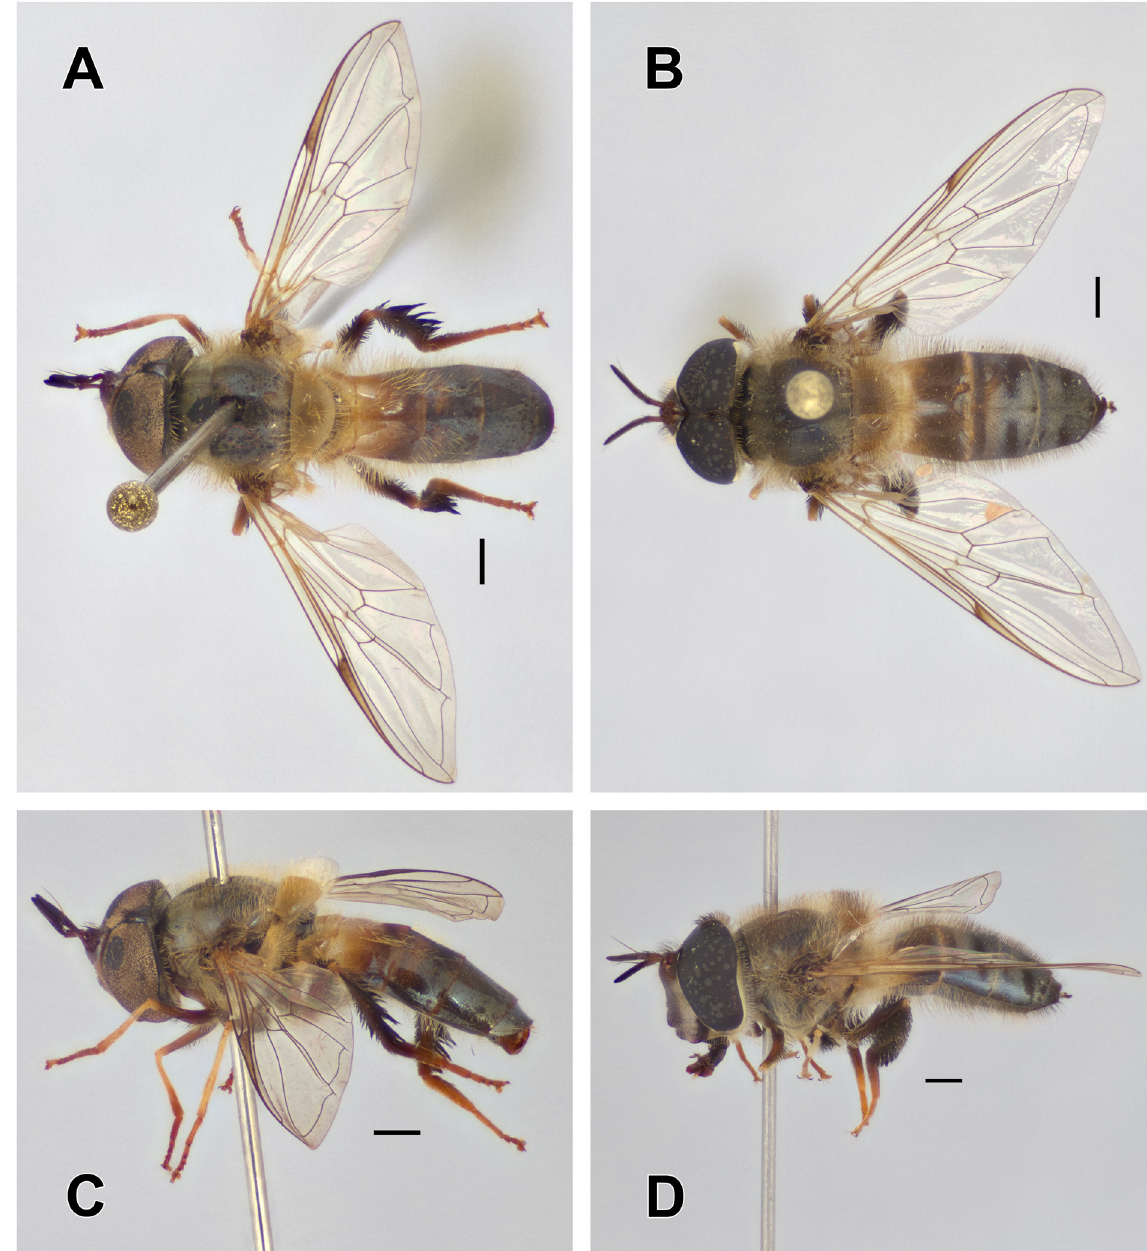
Fig. 3. A . Afrosyrphus varipes Curran, 1927, ♂ (ZFMK-DIP-00015968), dorsal view. B . Afrosyrphus schmuttereri sp. nov., paratype, ♂ (ZFMK-DIP-00019829), dorsal view. C . Afrosyrphus varipes , ♂ (ZFMK-DIP-00015968), lateral view. D . Afrosyrphus schmuttereri sp. nov., paratype, ♂ (ZFMK- DIP-00019829), lateral view. Scale bars: 1